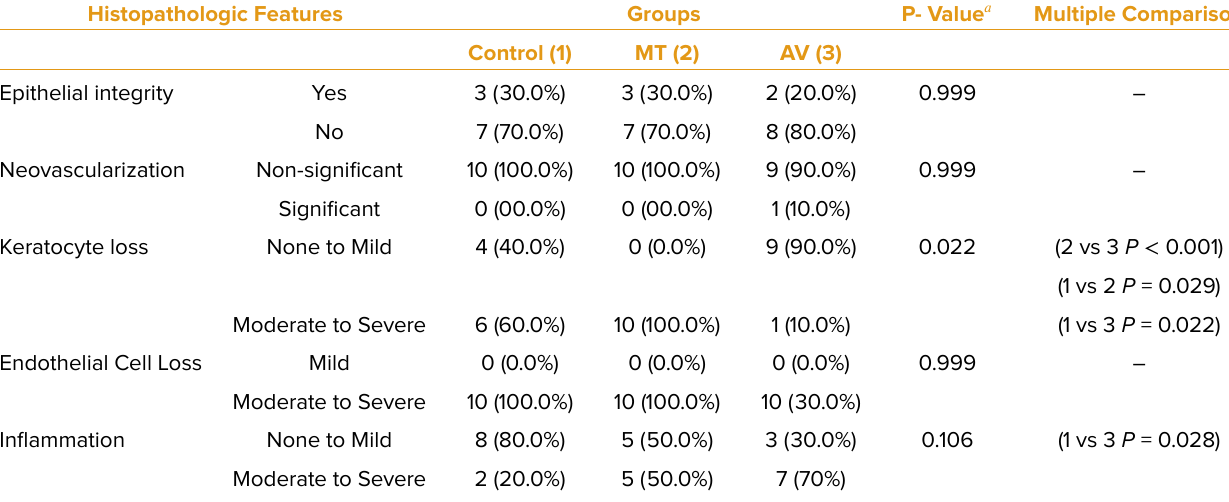
Table 3. Comparison of the histopathologic results of the corneal tissues among the Aloe Vera (AV), medical therapy (MT), and control groups Histopathologic